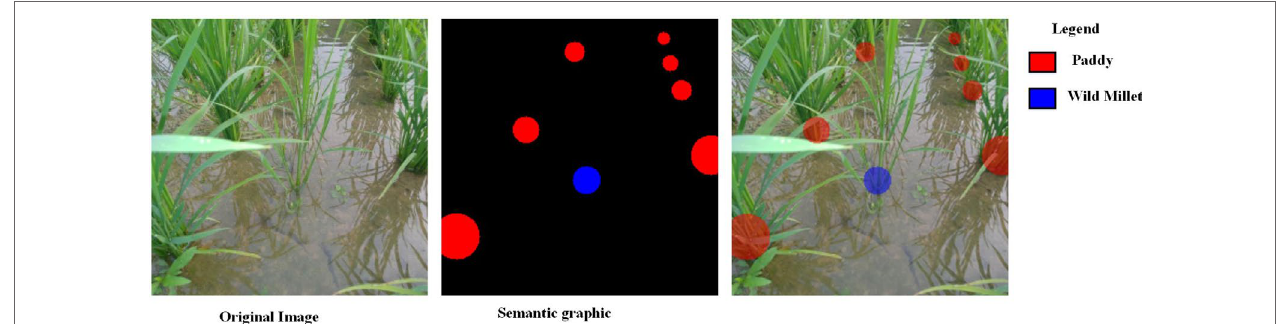
FIGURE 3 | Semantic graphics for paddy–millet dataset. (A) Image of a paddy field with wild millet. (B) Semantic graphics annotation. The color-filled circles used to annotate the base of the plants indicate multiple meanings such as category of the plant, location of the key-point, and their distance from a viewpoint. (C) Annotation superimposed on the source image. (Best viewed in color)